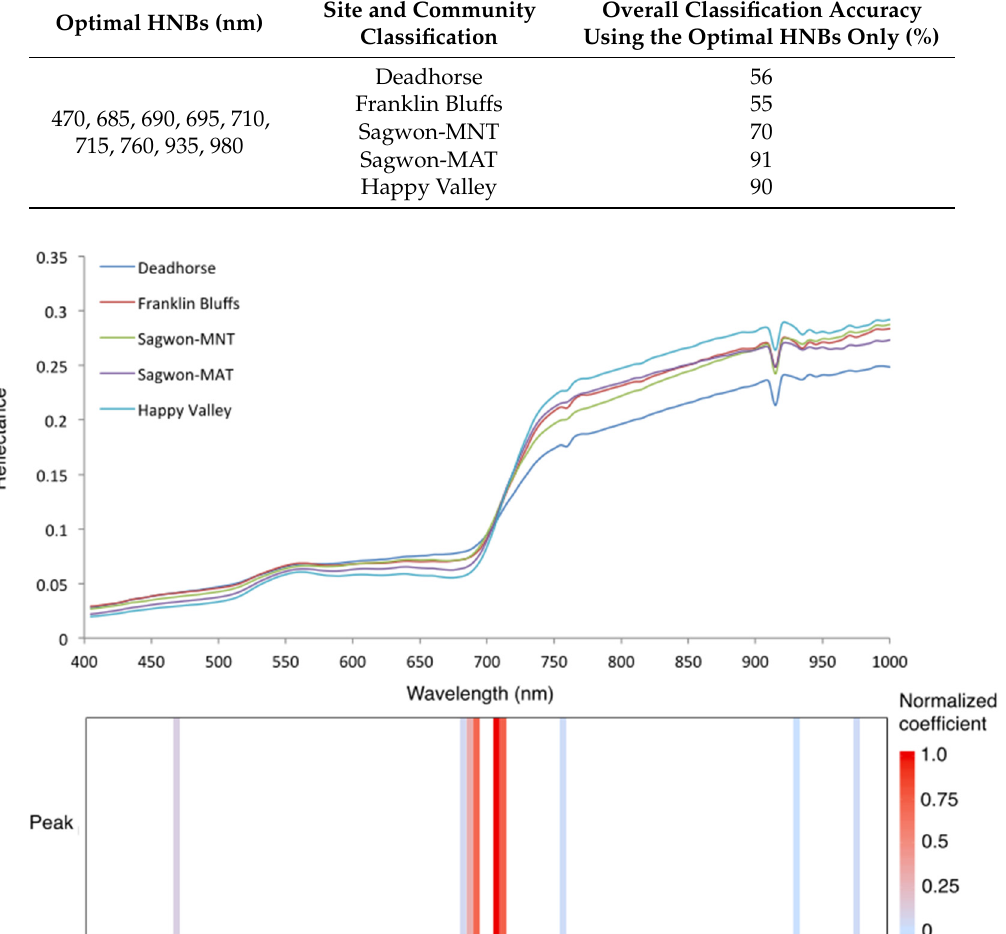
Figure 8. Mean reflectance spectra for the five Dalton Highway test sites. Reflectance spectra are shown along with the top ten percent of optimal hyperspectral narrowbands (HNBs) and their normalized coefficients for the first discriminant